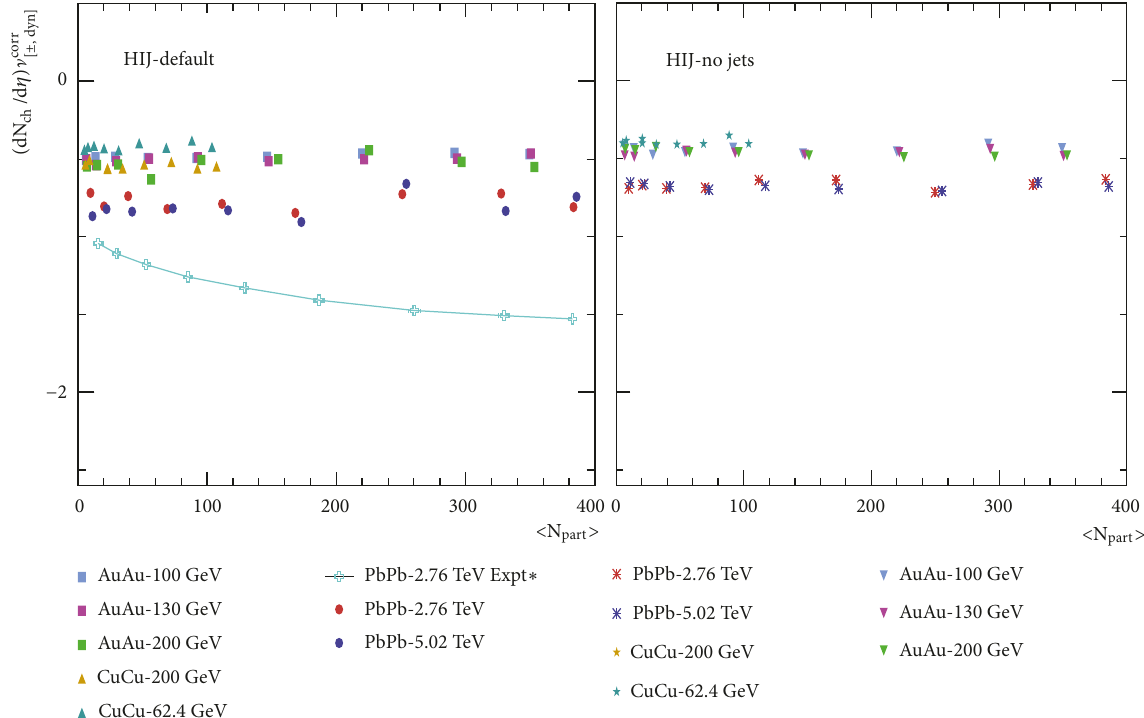
Figure 4: The same plot as Figure 3 but for corrected net charge fluctuations, ] 𝑐𝑜𝑟𝑟 [+−,𝑑𝑦𝑛] .